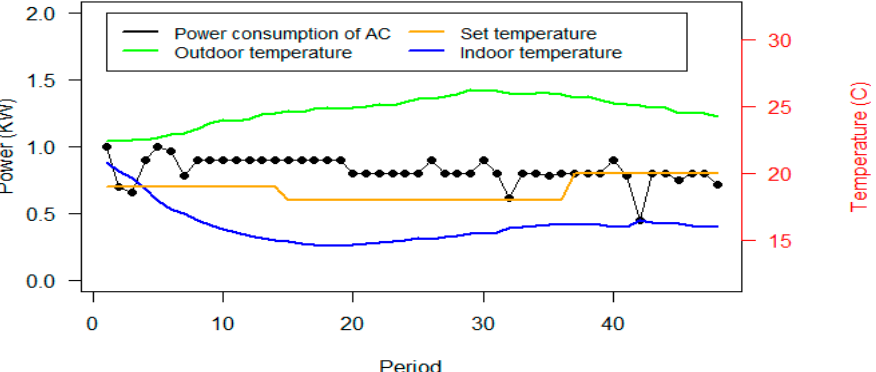
Figure 15. Power consumption of the AC and thermal parameters of Office #2, Day #13, scenario C.